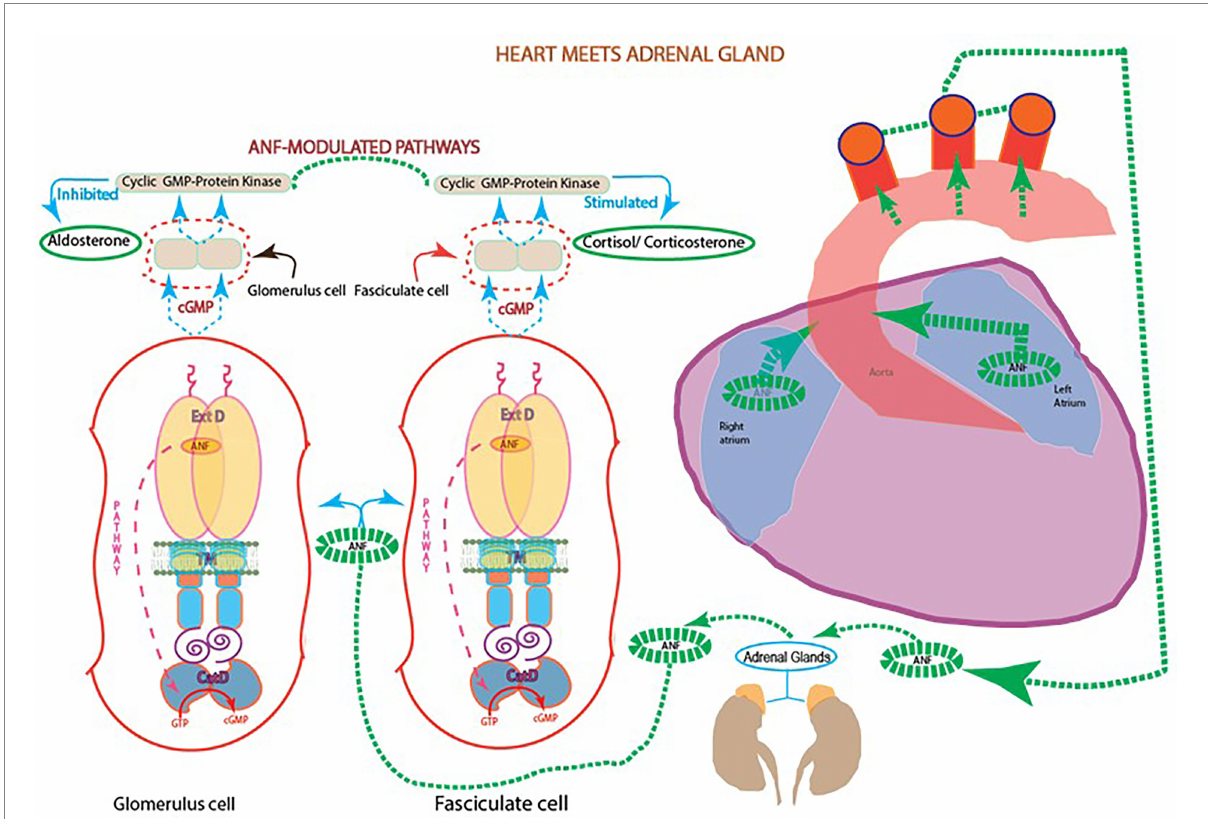
FIGURE 4 Heart meets adrenal gland: ANF reciprocal modulation of the two steroidogenic pathways. With every heartbeat, atria stretches and secretes ANF to the circulation. In the adrenal gland, ANF branches and initiates two signaling pathways involving cyclic GMP: one at the fasciculate cells to stimulate the production of cortisol/corticosterone; and the other at glomerular cells to inhibit the production of aldosterone and lower blood